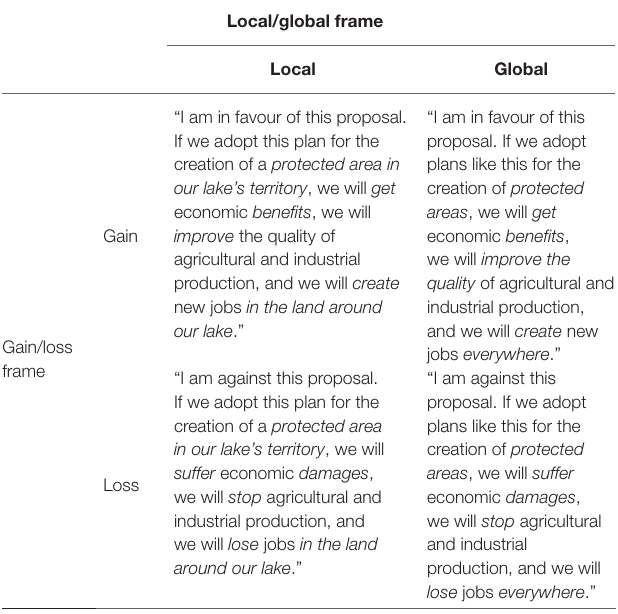
TABLE 1 | Messages on the economic consequences of the policy, manipulated as a function of gain/loss frame and local/global frame. Local/global frame